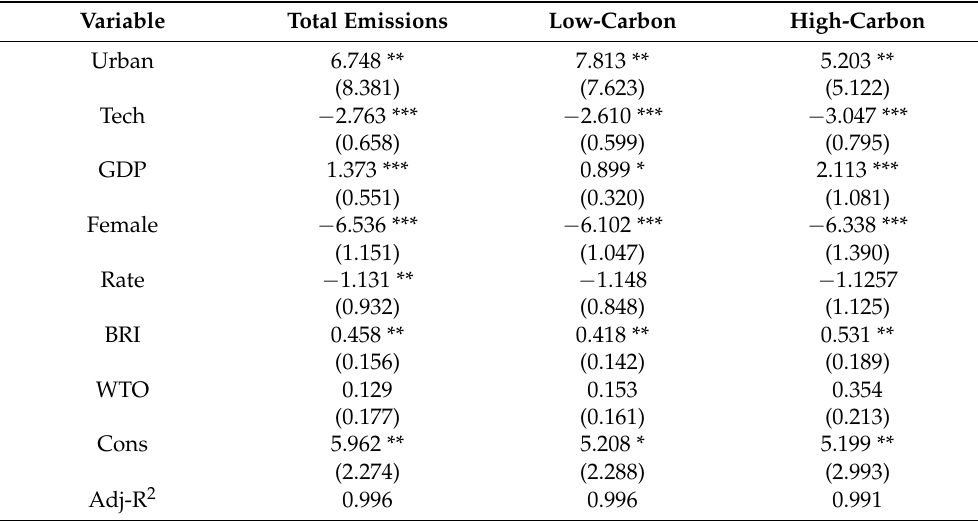
Table 3. The FMOLS regression results for total emissions, low- and high-carbon